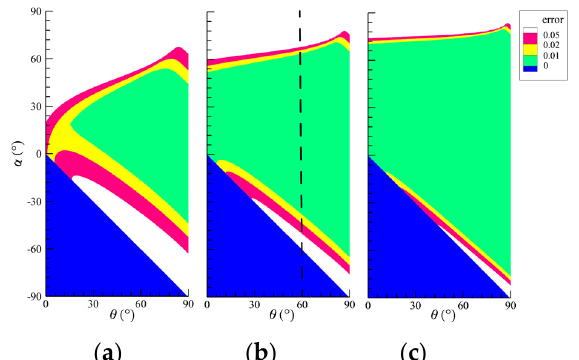
Figure 5. Maximum systematic error with different combinations of 𝜃 and 𝛼 : ( a ) d max / r = 1/3; ( b ) d max / r = 1/10; ( c ) d max / r = 1/33.